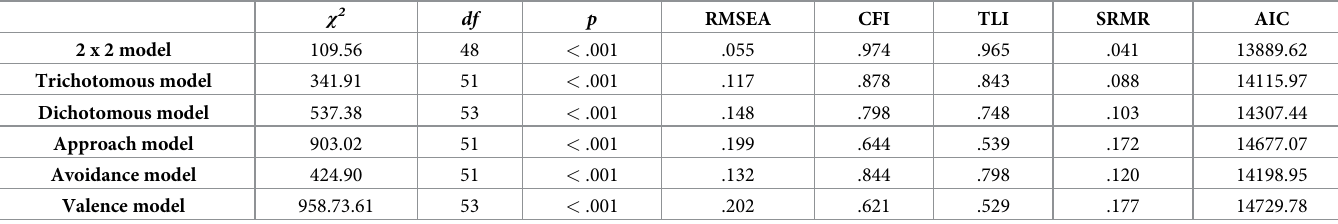
Table 4. Results of the confirmatory factor analyses for the 2 x 2 model (baseline model) and for five alternative models.